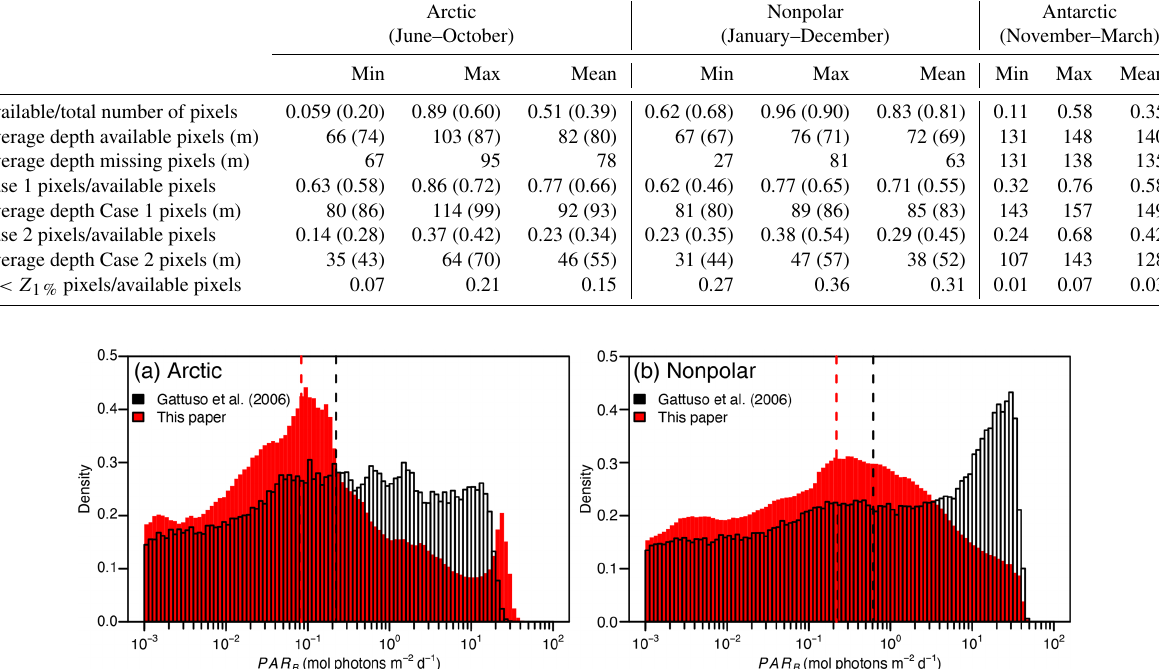
Table 3. Surface area and average depth of the various pixel classes. Calculations were performed on monthly data sets for the periods indicated. Values reported by Gattuso et al. (2006) are shown in parentheses for comparative purposes. Gattuso et al. (2006) did not report data for the Antarctic. Z 1% is the depth at which benthic irradiance or benthic PAR (PAR B ) equals 1% of surface irradiance or PAR. Available pixels are the pixels for which PAR, K PAR , C sat , and R rs (555) are available for analysis. Arctic